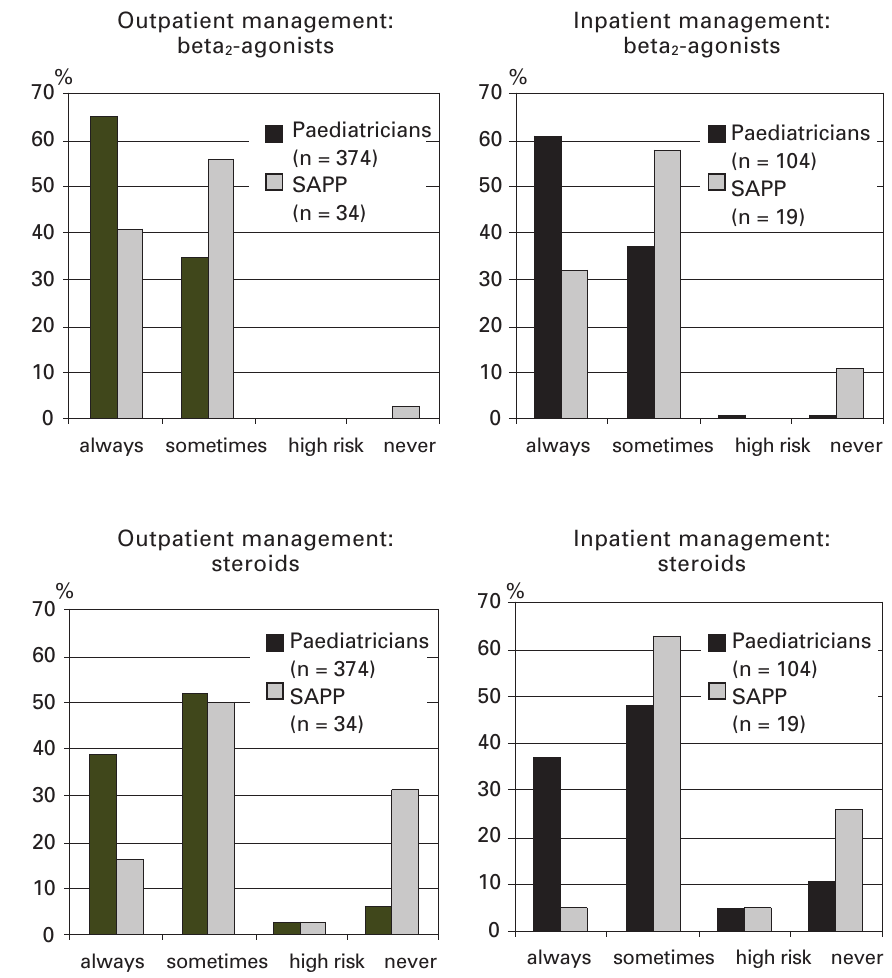
Figure 1 Comparison of pre- scribing habits for beta 2 -agonists and corticosteroids between general paediatricians ( ! ) and members of the Swiss Paediatric Pulmonology Group (SAPP) ( !